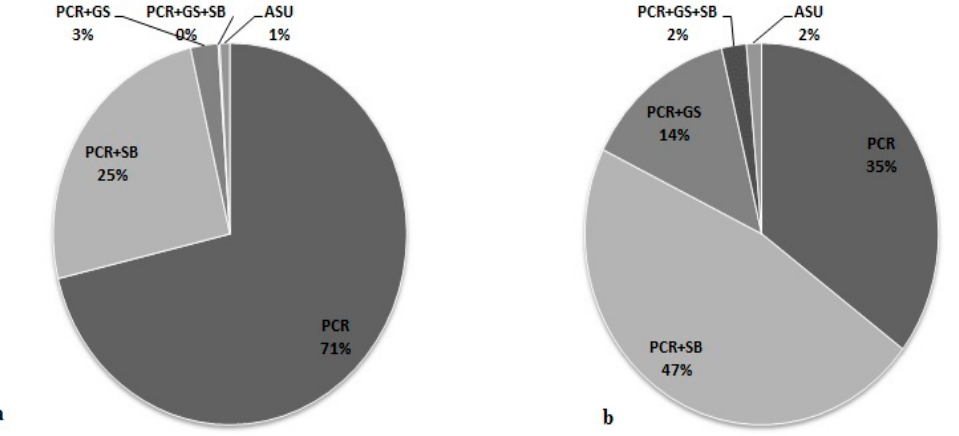
Figure 1. Percentage of molecular methods used to proper differantiation of the FMR1 alleles. PCR—polymerase chain reaction, GS—Gene Scan, SB—Southern blot, ASU—Amplidex FMR1 PCR kit, Asuragen. ( a ) Female; ( b ) Male.